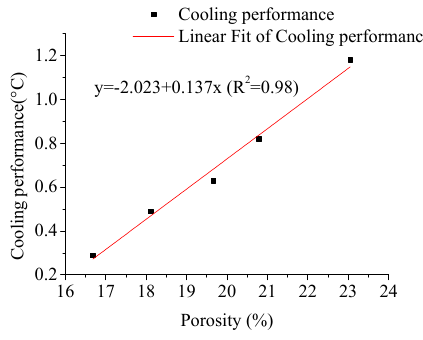
Figure 12. Relationship between the cooling performance and porosity.